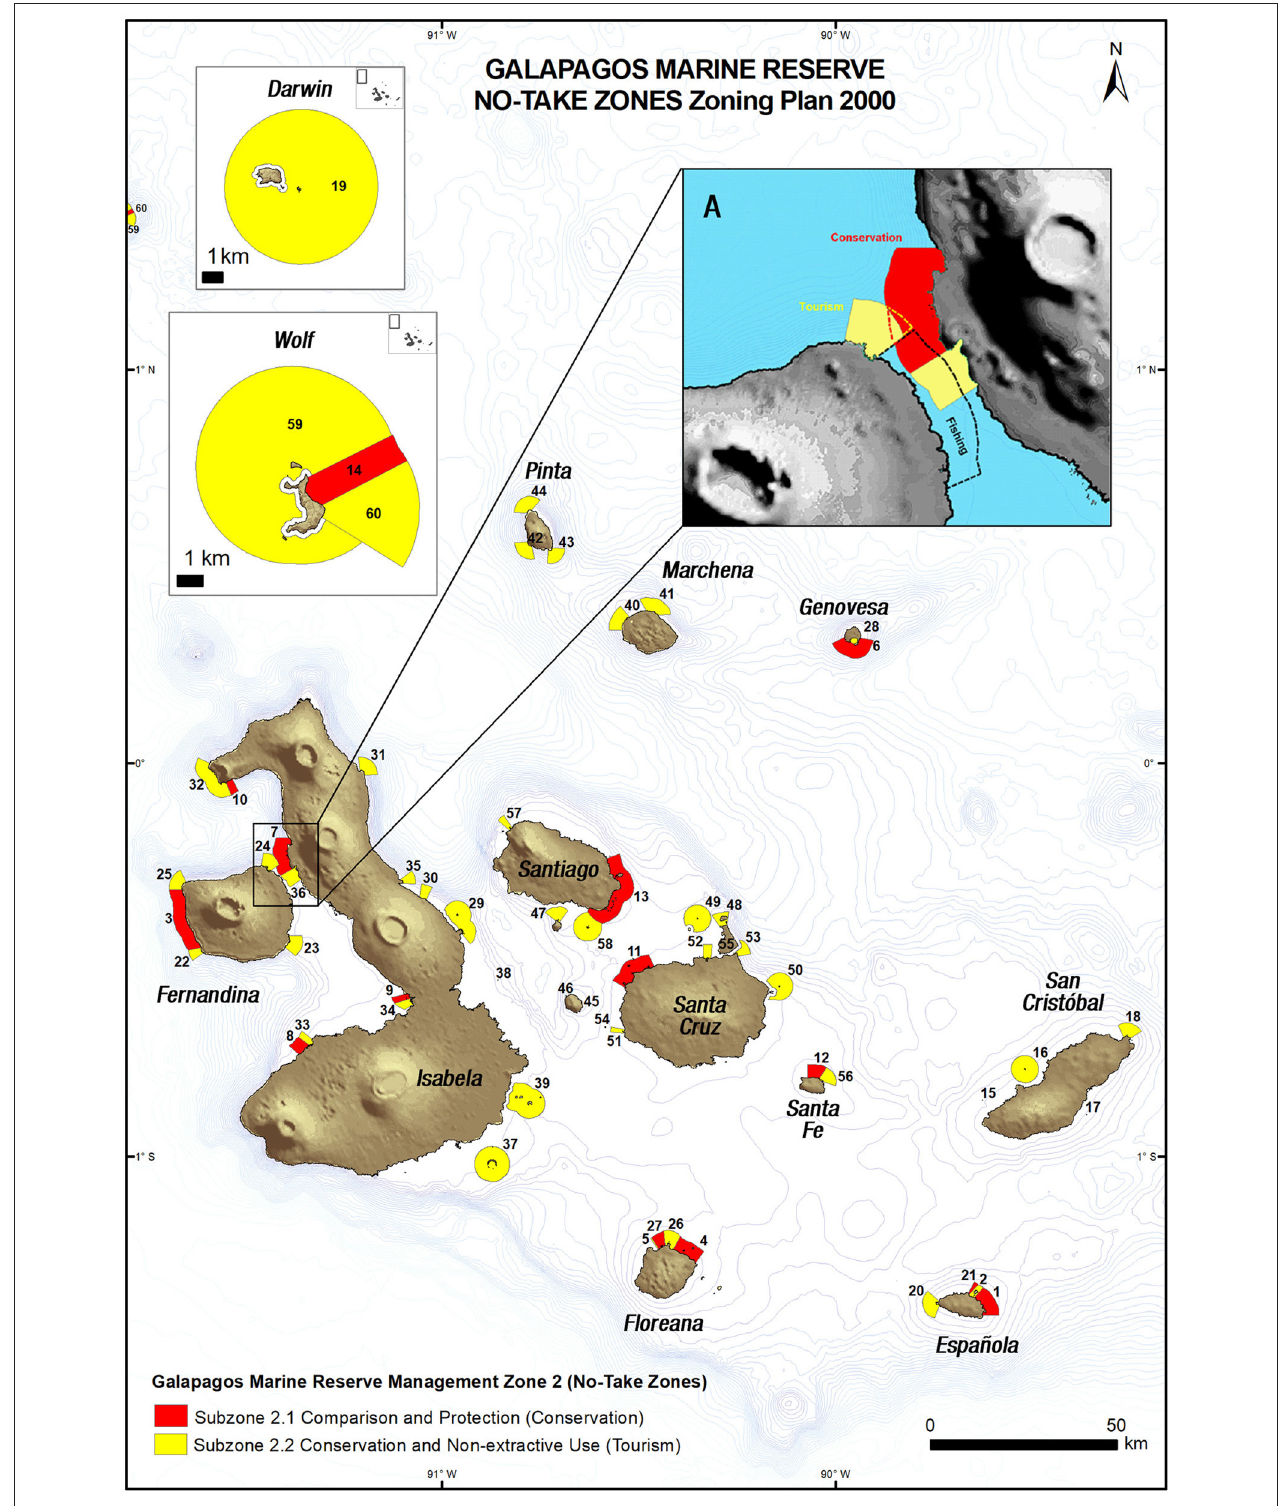
FIGURE 1 | Map of the Galapagos Marine Reserve Zoning Plan 2000 for No-Take Zones. No-Take subzones numbers refer to the subzone id and are depicted in Supplementary Table 1. Bathymetry shows isobaths at 100m intervals. (A) inset shows an area where several subzones overlap creating potential conflicts between different